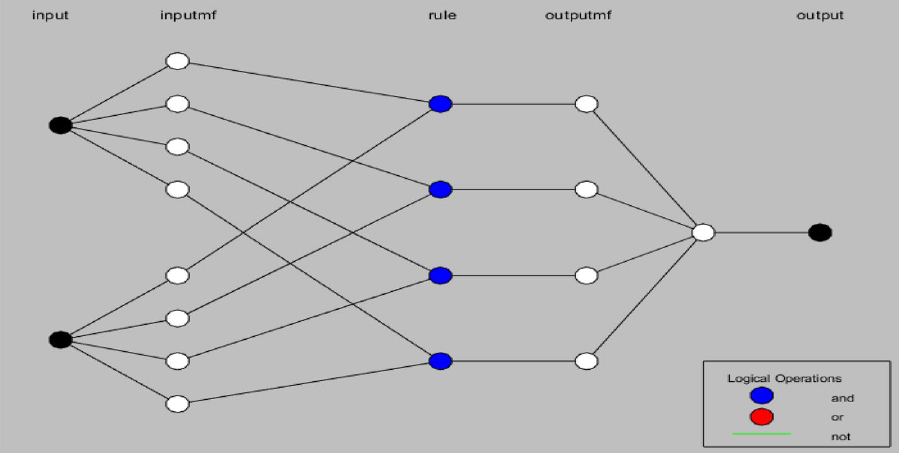
Figure 3. ANFIS-EEBAT structure. It contains five layers, as discussed in Fig. 1. There are two inputs, four pairs of input MFs, four set of rules, four output MFs and one output. The two inputs are “No. of Story Points” and “Velocity”. The output is “Estimated Effort”. The operations performed at different layers are synonymous with the description in Fig. 1. There are three basic logical operations, “and”, “or”, “not” depicted in the figure with three color codes “blue”, “red” and “green” respectively. The rules are created using logical “and” operation in our case. The logical “or” and “not” operations are